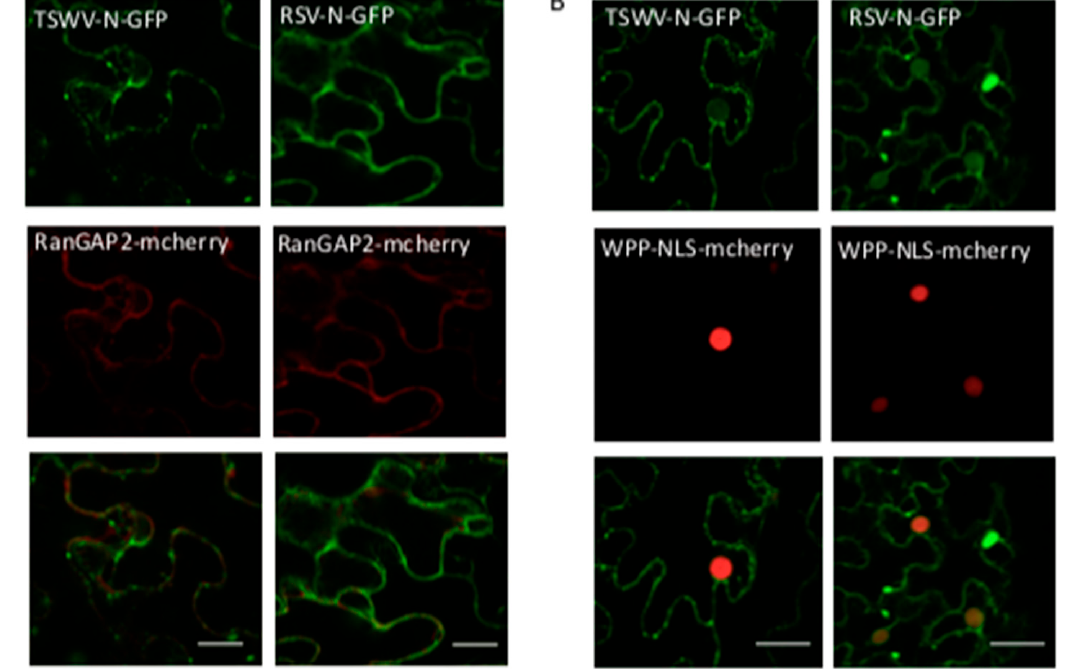
Figure 8. Co-localization analysis of TSWV and RSV N proteins with AtRanGAP2 and the effect of RanGAP silencing on TSWV replication. ( A ) Localization of RSV and TSWV N-GFP protein relative to AtRanGAP2-mcherry in plant cells. Bar presents 10 µm. ( B ) Localization of RSV and TSWV N- GFP protein relative to WPP-NLS-mcherry in plant cells. Bar presents 10 µm. ( C ) Plant phenotype after VIGS-silencing RanGAPs , compared with the GUS -silenced control plant. ( D ) qRT-PCR assay to quantify the silencing efficiency. *** p -value < 0.001. Delta Ct values are shown on Y-axis. ( E ) Green fluorescence resulting from eGFP expression from a TSWV replicon in plants silenced on RanGAP (s), and control plants. Plants were infiltrated with TSWV-eGFP replicon constructs 2.5- week post silencing and harvested at around 60 hpi. ( F ) Statistical analysis of eGFP intensity in the silenced plants and control plants. 3.7. TSWV Cleaves Transcripts That End Up at Different Locations To further analyze the (relative) usage of transcripts from PBs and SGs during TSWV cap snatching/transcription various synthetic transcripts, designed to end up to at PB or SG or reflecting a canonical mRNA, were simultaneously offered to TSWV in plants and